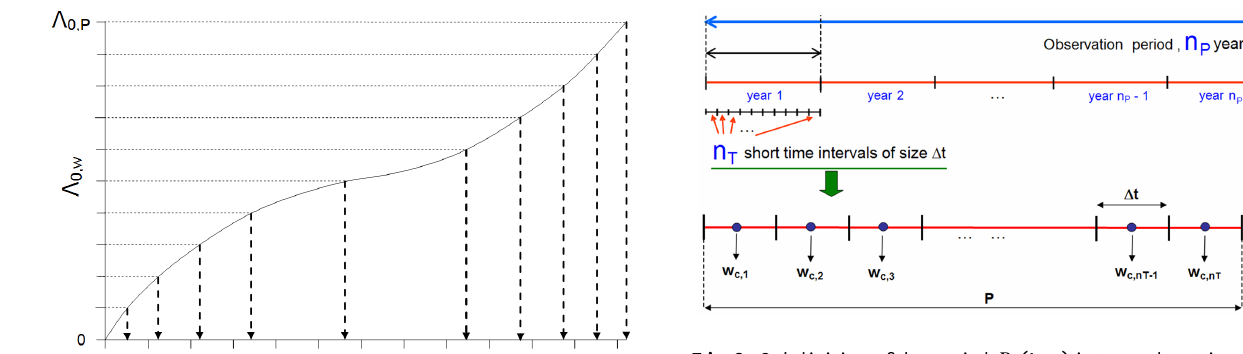
Fig. 3. Subdivision of the period P (1yr) into n T short time inter-